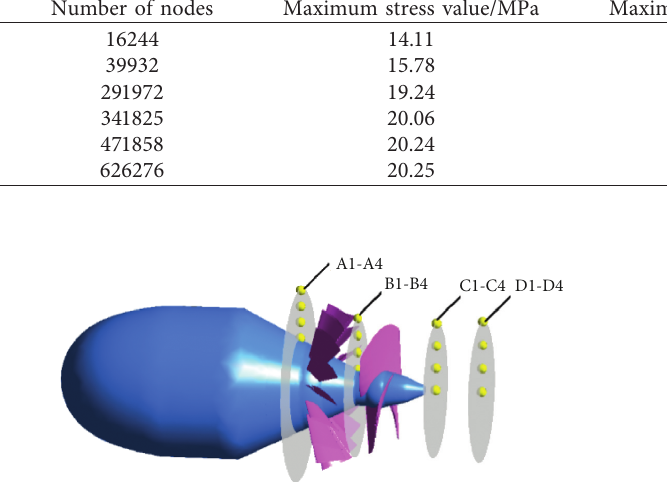
Figure 7: Layout of monitoring